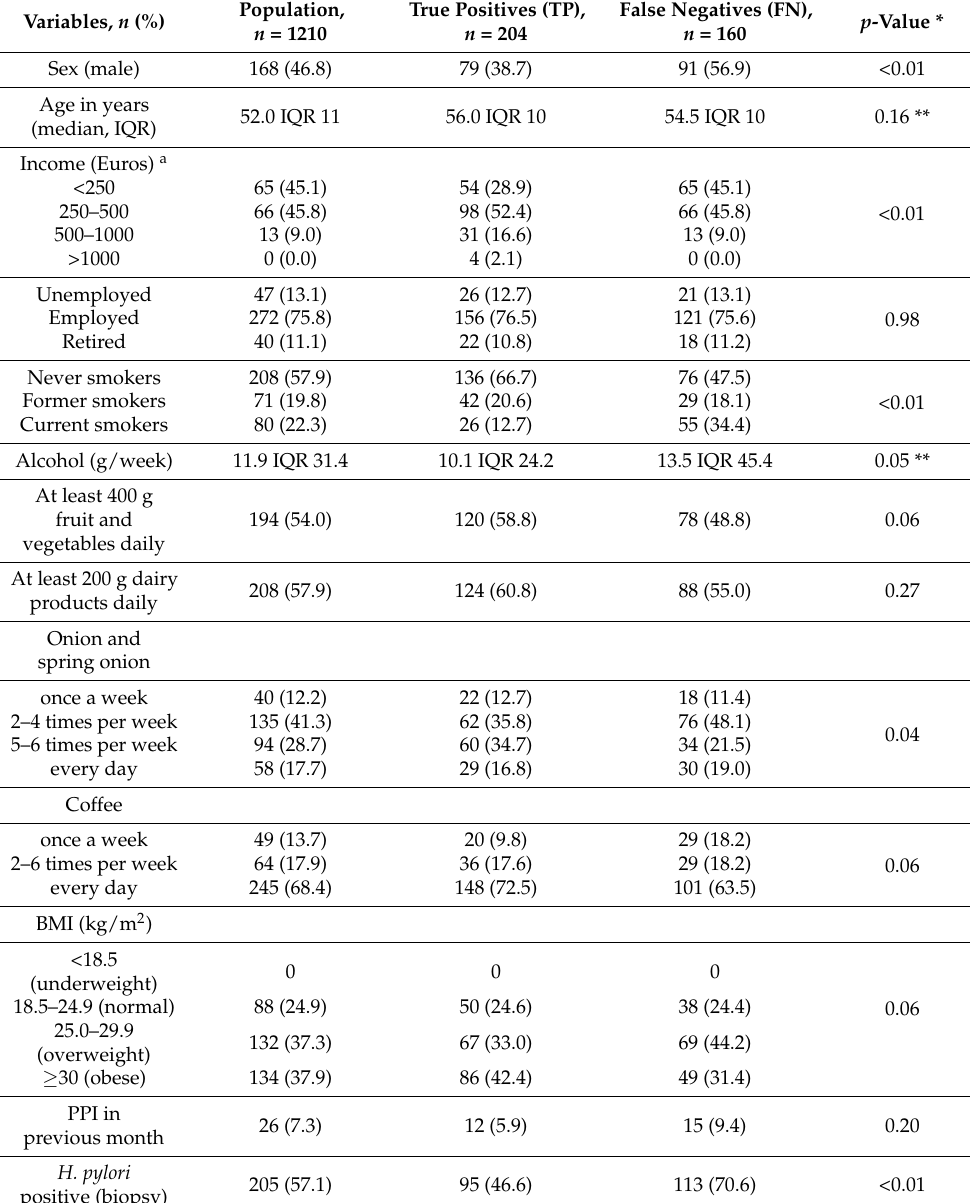
Table 1. Comparison of factors between false negative and true positive cases in detecting precancer- ous gastric lesions by pepsinogen